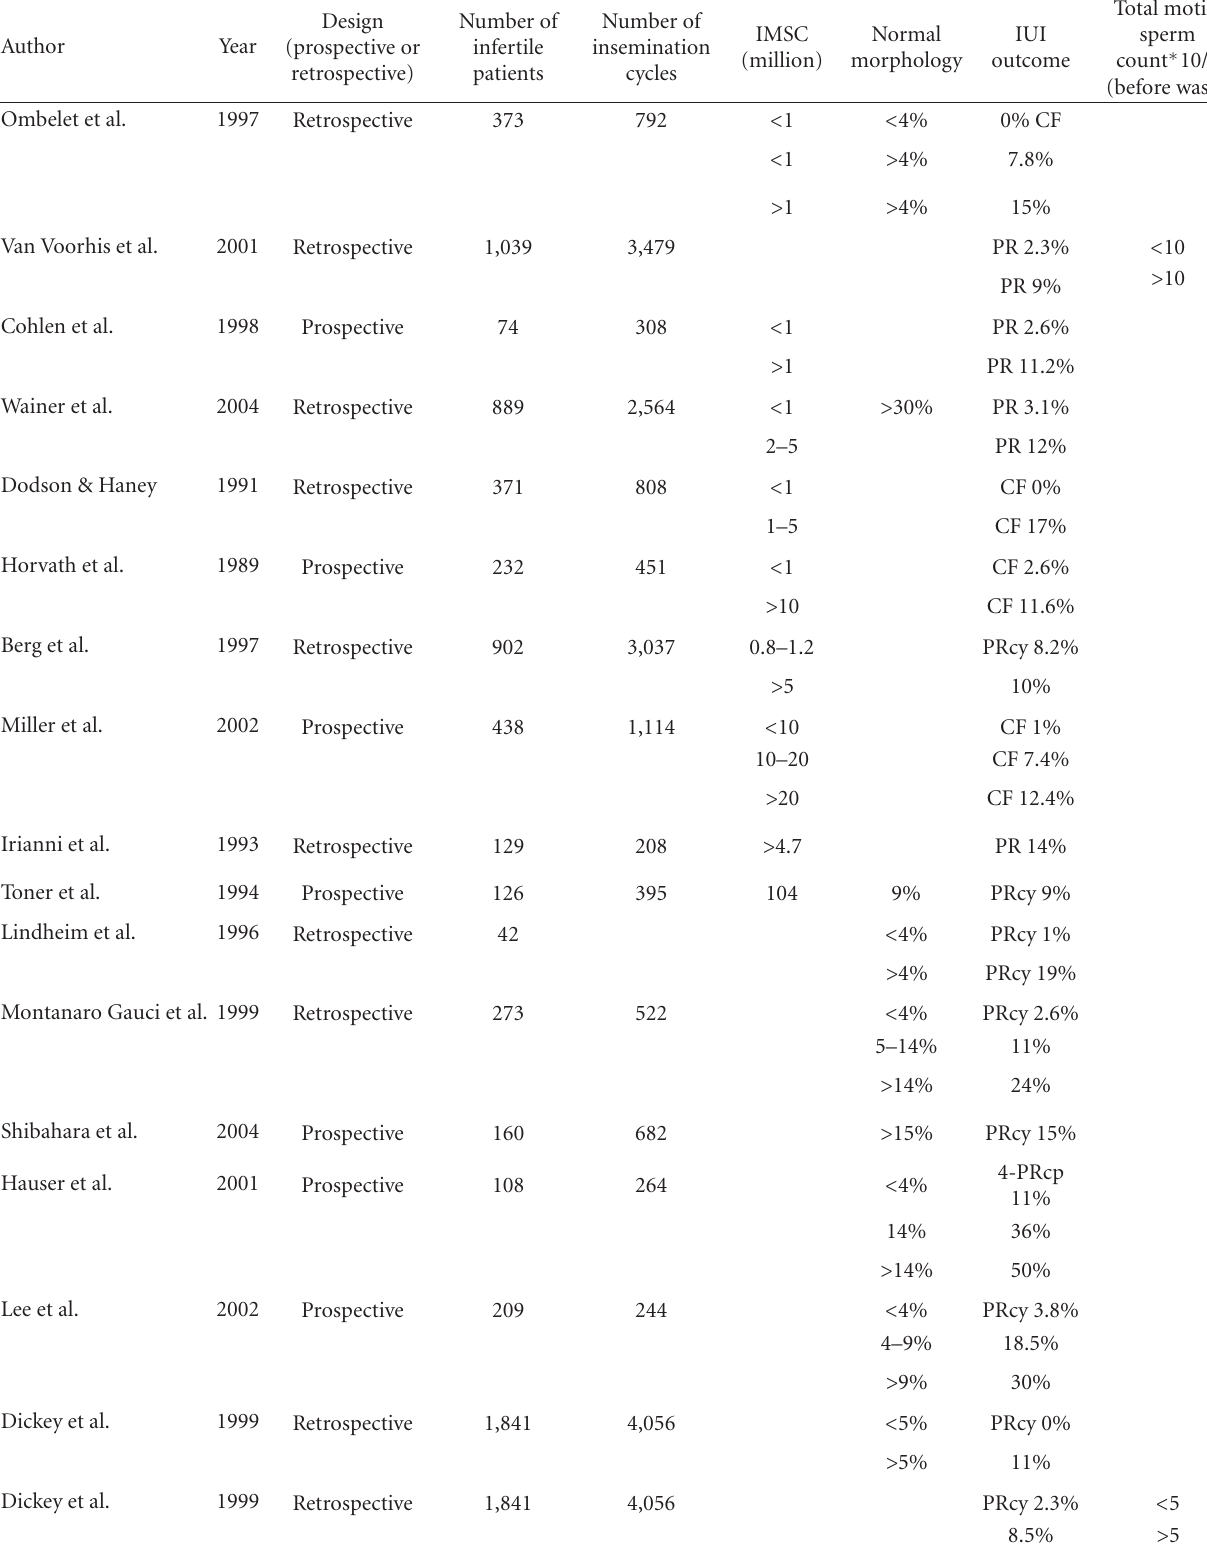
Table 1: Motile sperm concentration, normal morphology, and IUI